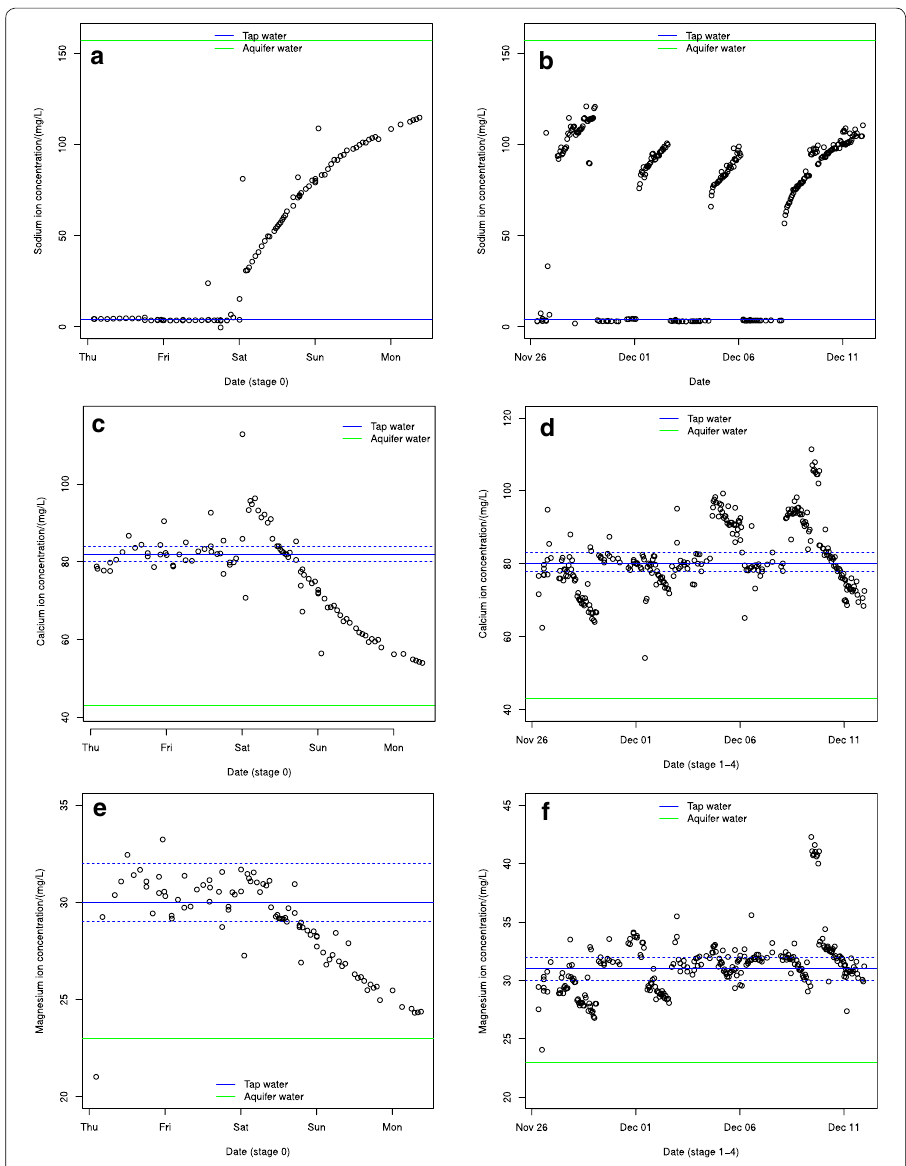
Fig. 10 Development of the sodium ion concentrations during stage 0 (upper left: a ) and during stages 1–4 (upper right: b ), calcium ion concentrations during stage 0 (middle left: c ) and during stages 1–4 (middle right: d ) and magnesium ion concentrations during stage 0 (bottom left: e ) and during stages 1–4 (bottom right: f ). The reservoir water concentration is shown as a green line and the median of the injected tap water as a blue line (25 and 75 % quantile is shown as a dashed blue line). The samples were taken at the bypass (see Fig.